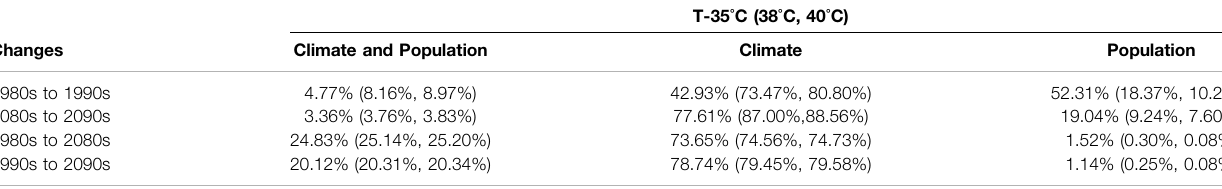
TABLE 1 | Analysis of factors affecting changes in population exposure to extremely high temperature in Southern China.